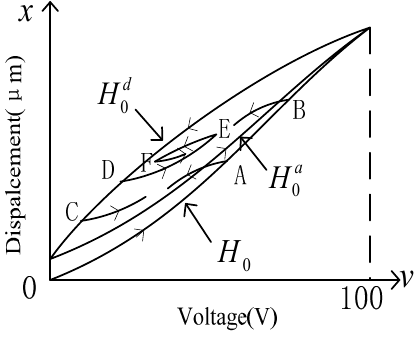
Figure 11. The general view ofturning points.